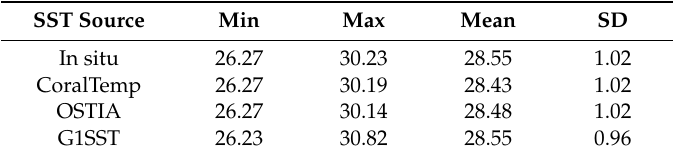
Table 5. Summary of the SST data ( ◦ C) for Margarita Reef from 1 March 2019–24 December 2019 (~10 months) for the averaged in situ loggers, CoralTemp, and OSTIA. The G1SST dataset is only